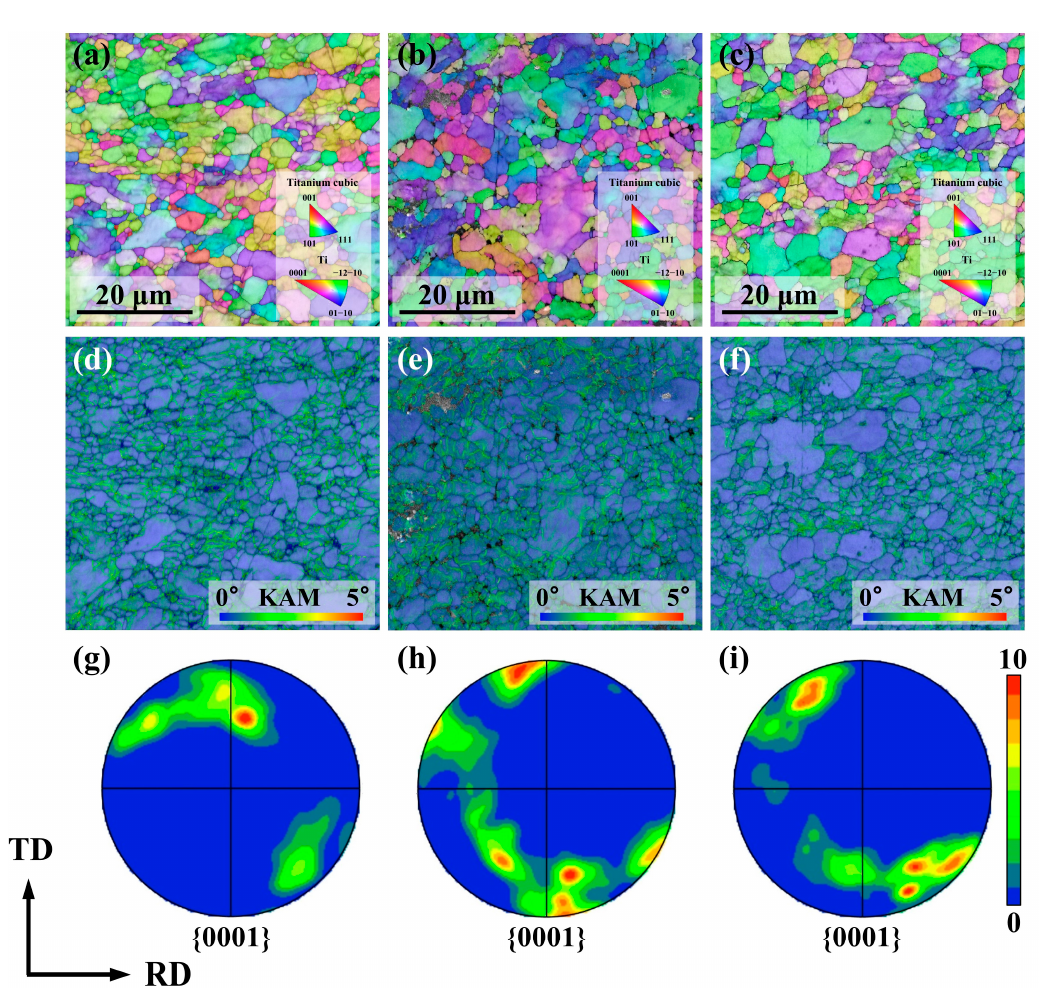
Figure 5. EBSD inverse pole figures (IPFs) of the ( a ) RD sample, ( b ) TD sample, and ( c ) DD sample at the strain of 8%. ( d – f ) shows the kernel average misorientation (KAM) maps of ( a – c ). ( g – i ) shows the PFs of ( a – c ).